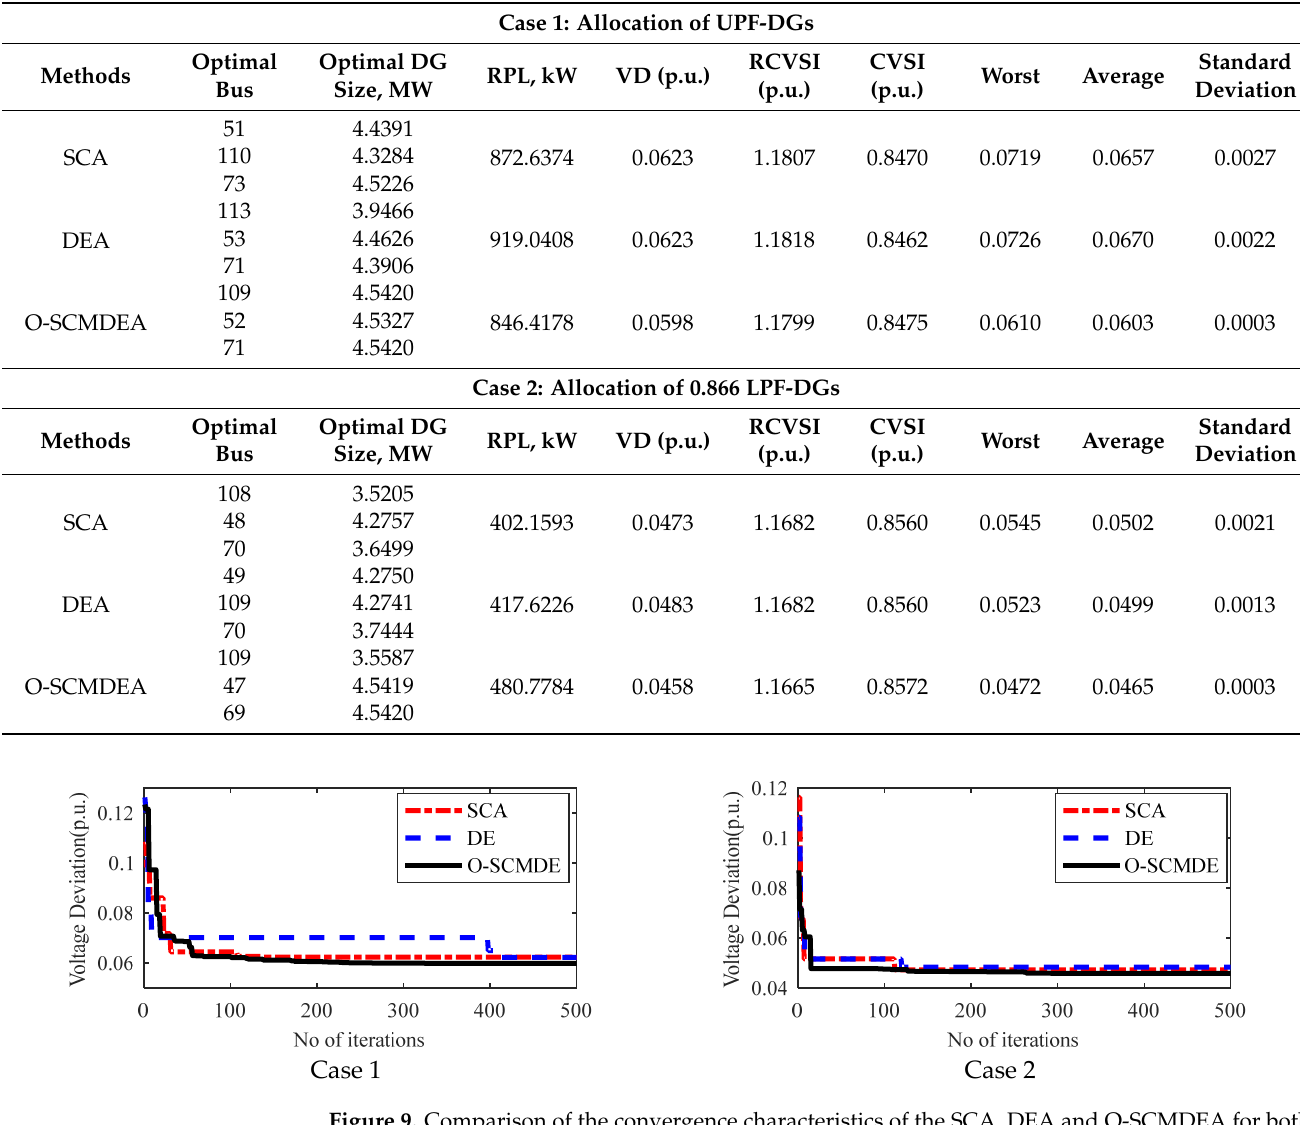
Figure 9. Comparison of the convergence characteristics of the SCA, DEA and O-SCMDEA for both cases of scenario II of the 118 bus system.